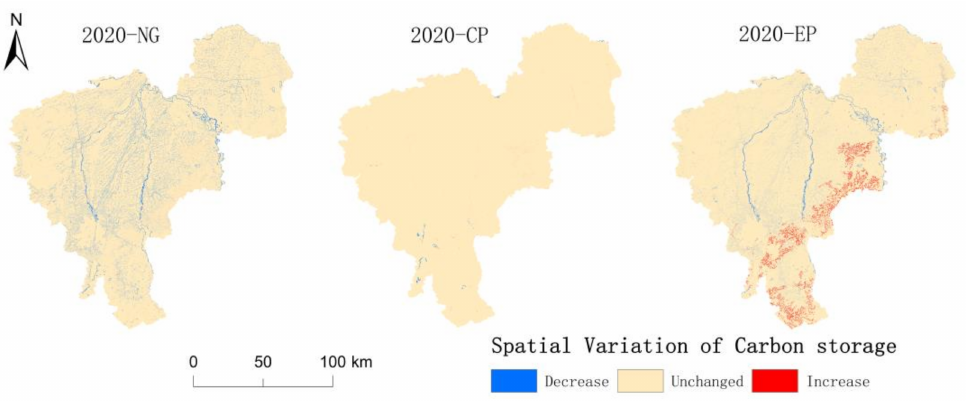
Figure 7. Potential spatial variation of carbon storage from 2020 to three scenarios in